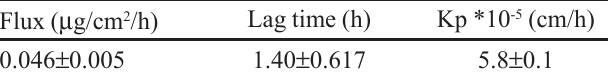
TABLE VI - Flux, lag time and permeability coefficient (Kp) of mometasone furoate through skin membrane (mean ± SD; n = 6).